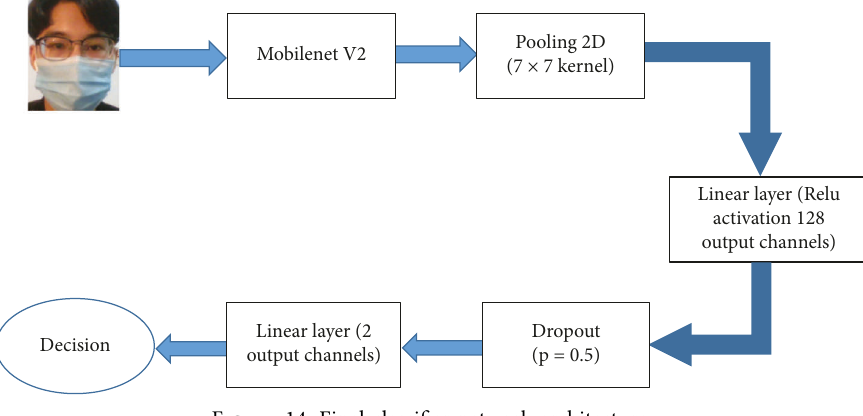
Figure 14: Final classifier network architecture.